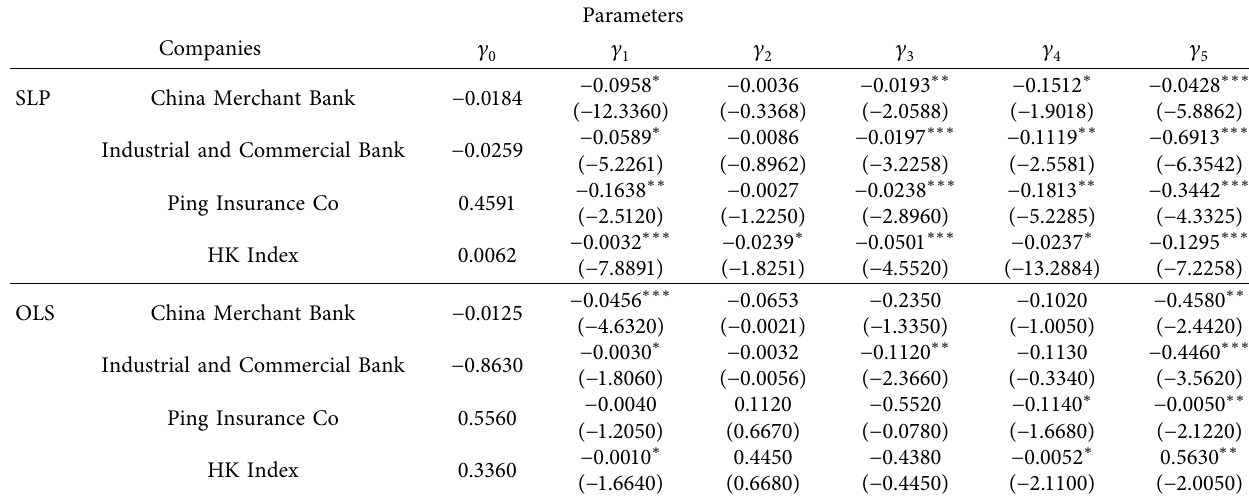
Table 11: Coefficient outputs for Hong Kong with